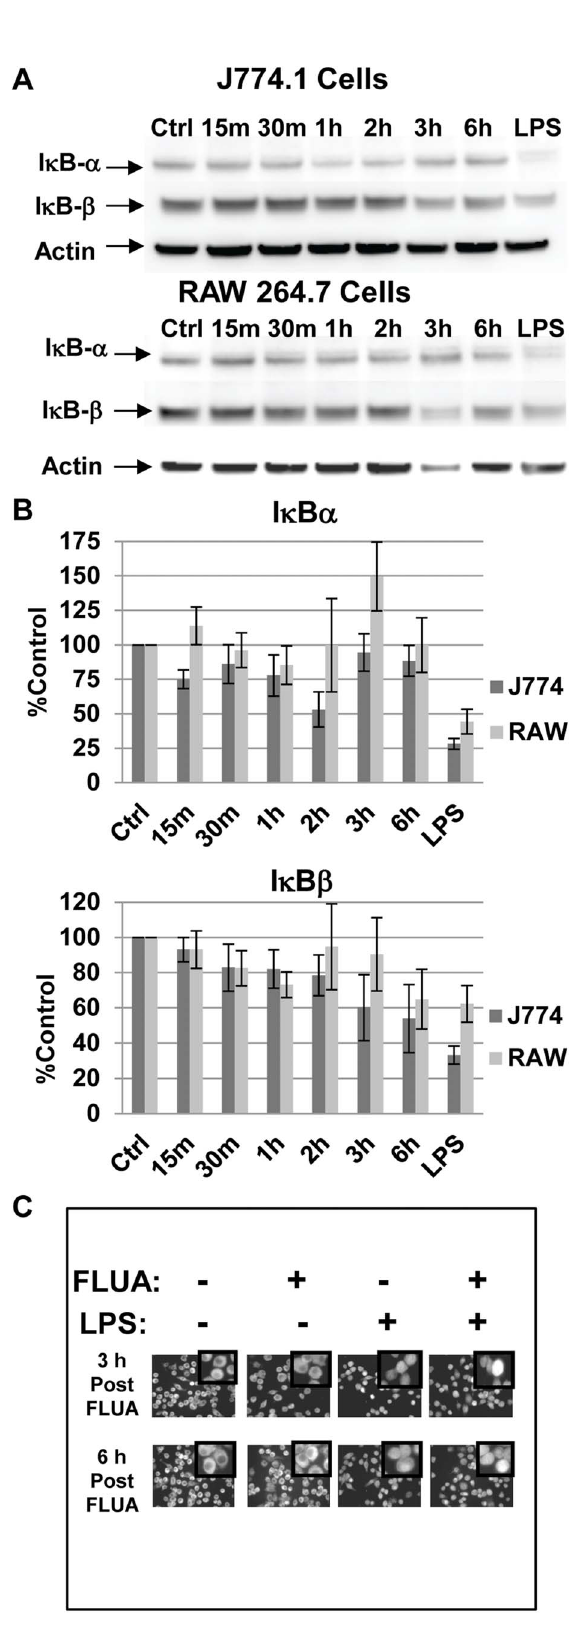
Figure 1. NFkB is not activated by FLUA at early time-points. A. In J774.A1 cells I k B a levels were reduced at 2 h while I k B b levels showed a gradual decline across the time points (but approximated control levels at 2 h). In RAW 264.7 cells, I k B a stayed near or